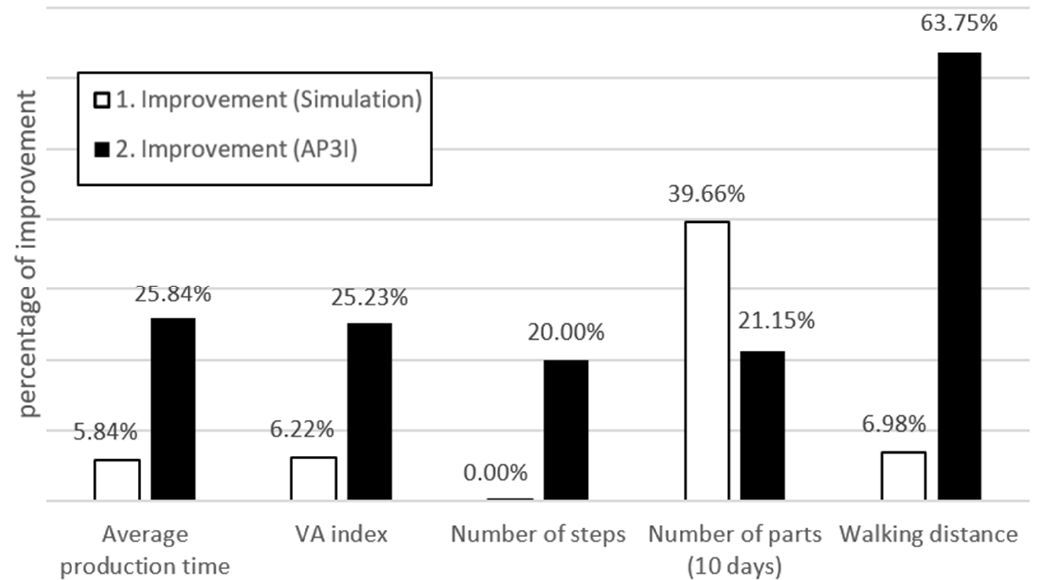
Figure 11. The comparison of relative improvement rates of process indicators—assembly line.